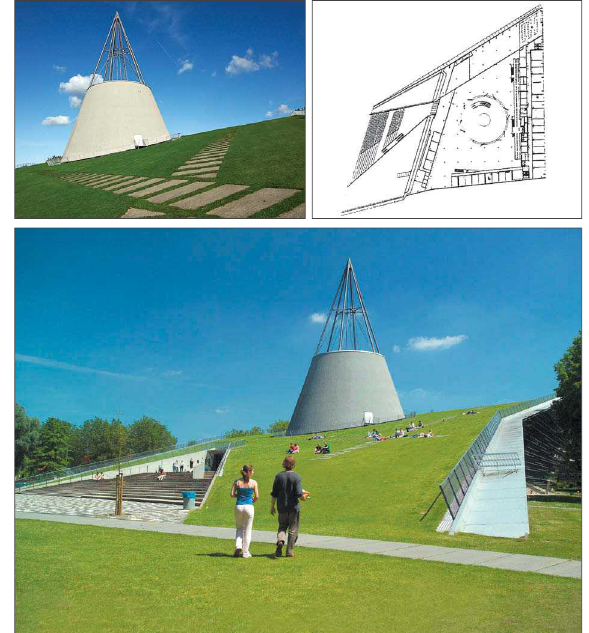
(1996 m.) Fig 1. Library of Porto University, Engineering Faculty in Portugal, (1996)